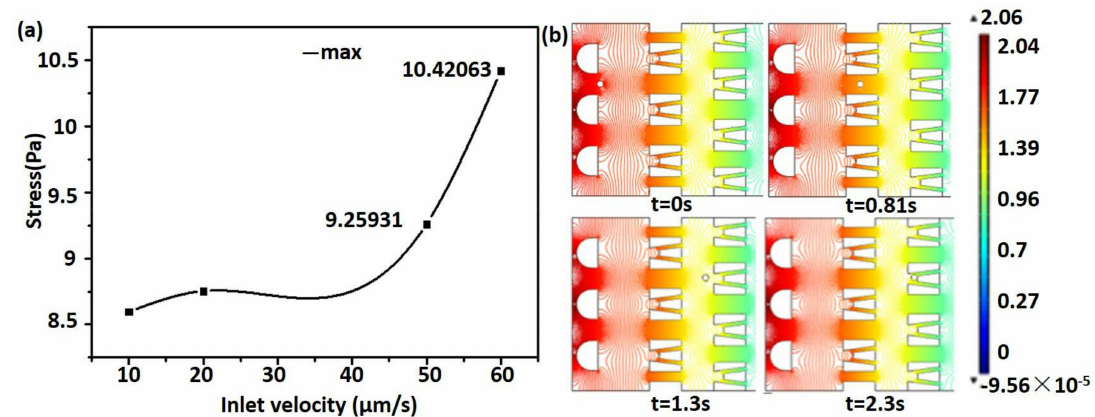
Figure 7. ( a ) The equivalent stress of the microsphere at different inlet velocities; ( b ) The fluid pressure in the chip at a velocity of 50 µ